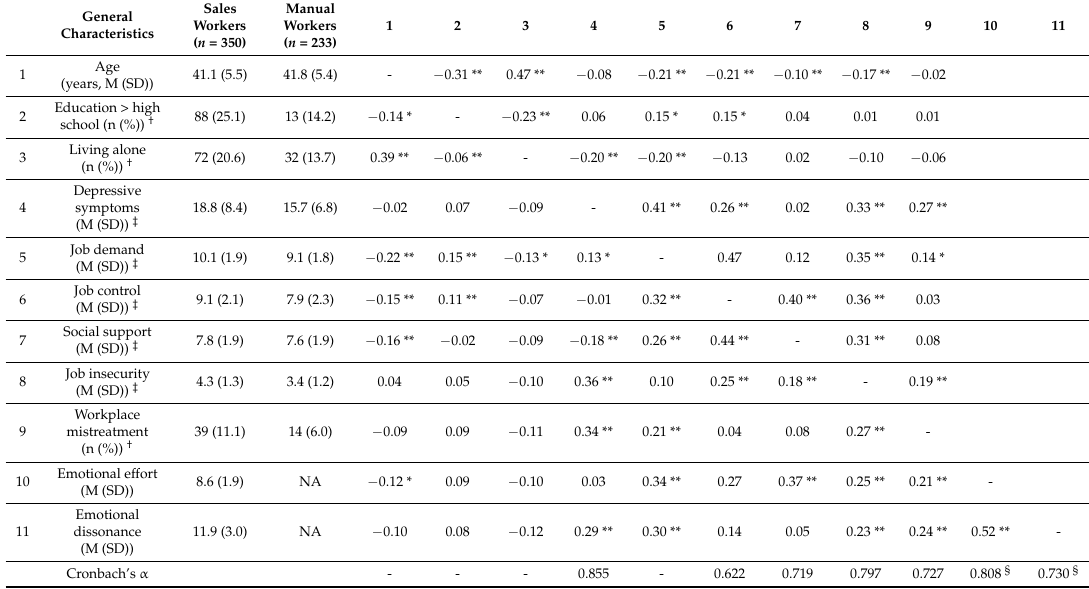
Correlation coefficient for sales workers were presented in the gray color cell. Those for manual workers were in the non-colored. † p < 0.01 from chi-square test, ‡ p < 0.01 from independent t -test, * p < 0.05, and ** p < 0.05 from Pearson’s correlation test, § Cronbach alpha values only from sales workers’